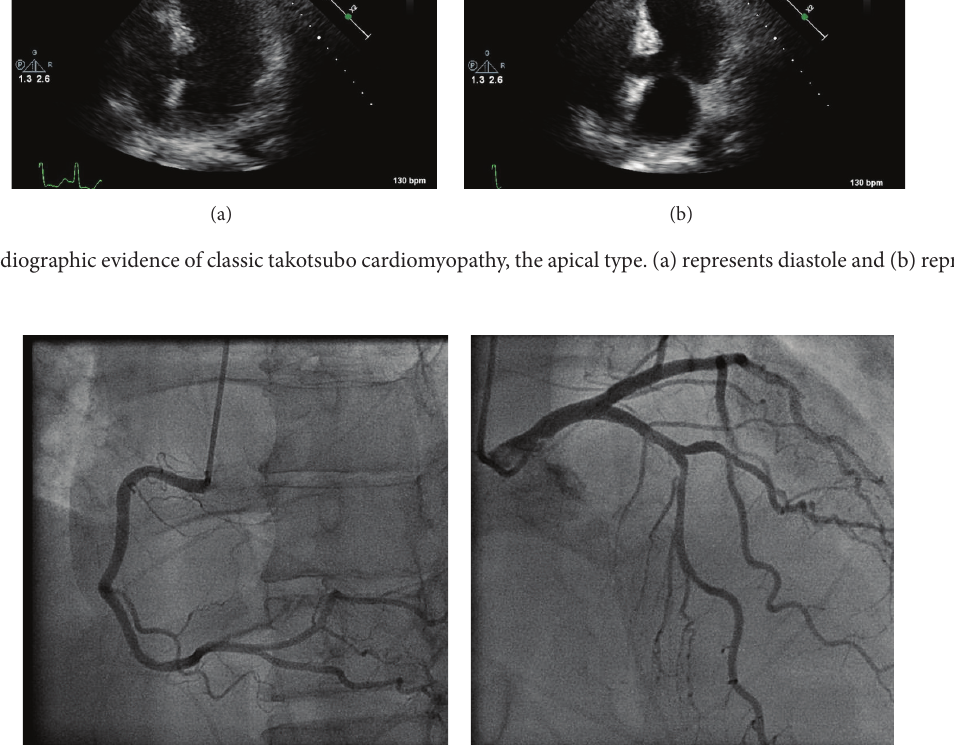
Figure 6: Angiogram reveals normal coronary